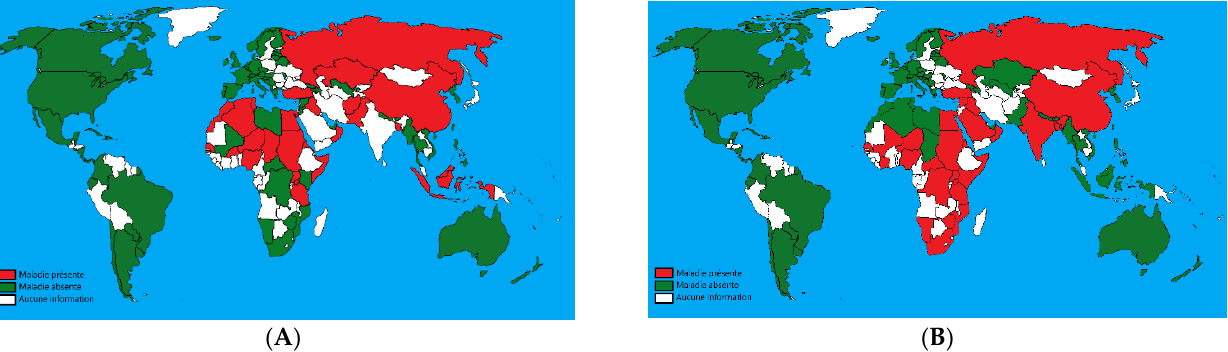
Figure 1. ( A ): Geographical distribution of sheeppox; ( B ): geographical distribution of lumpy skin disease (Adapted from World Animal Health Information Database (WAHIS), 2020). Green: absence of the disease; red: presence of the disease; white: unavailable data.